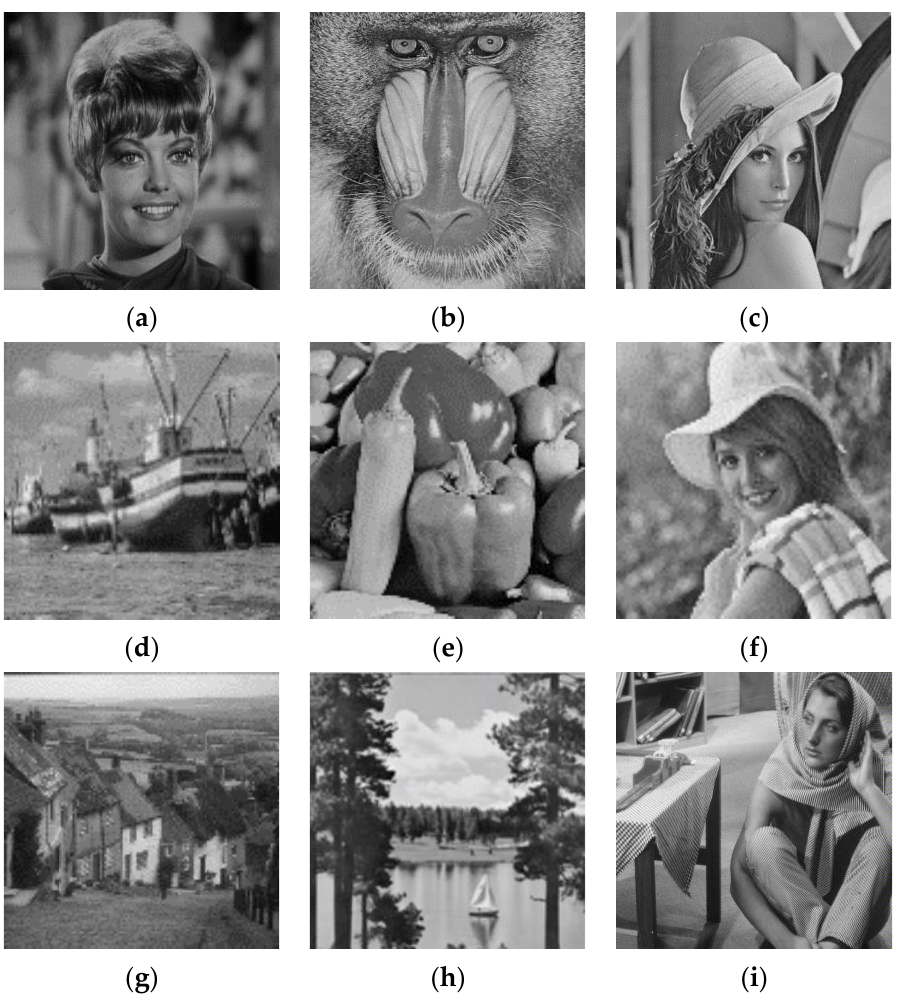
Figure 5. The 512 × 512 grayscale images used in the experiments. ( a ) Zelda, ( b ) Baboon, ( c ) Lena, ( d ) Boat ( e ) Peppers, ( f ) Elaine, ( g ) Goldhill, ( h ) Lake, and ( i ) Barbara.